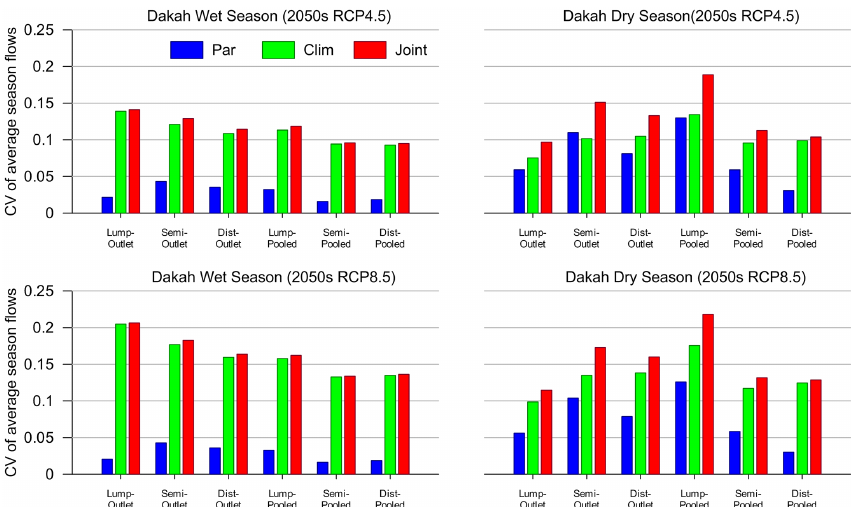
Figure 11. Uncertainties in wet and dry season average streamflow predictions for 2050s are derived from the basin outlet and pooled calibrations for Dakah. Uncertainties are evaluated by the CV of average season streamflow predictions. Three uncertainty sources are considered: calibration uncertainty across 50 calibration trials (Par), climate uncertainty across GCM projections (Clim), and combined uncertainty